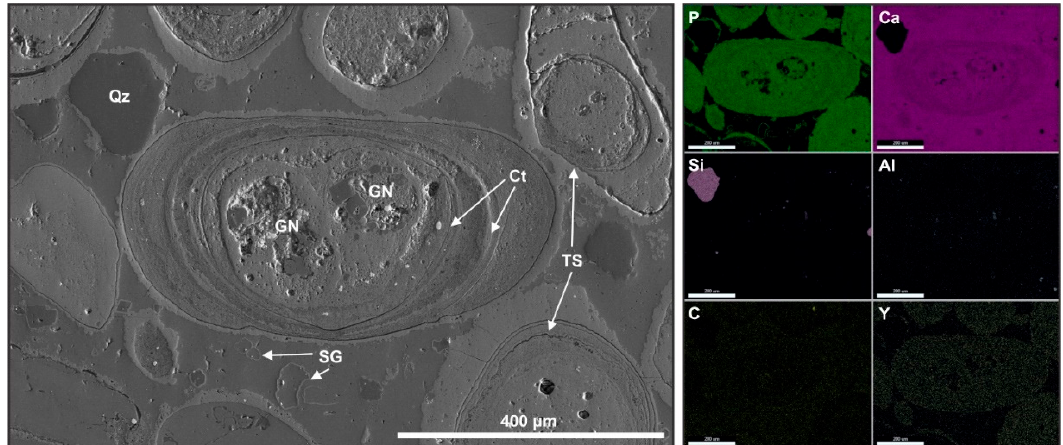
Figure 7. Detailed SEM image of sample MH6 centered on composite apatite coated grain, acquired with ET detector BSE mode, and SDD-EDS elemental maps of select major and trace elements. The grain in the center is formed by the agglutination of two apatite grains with aluminosilicate nuclei (GN) and multiple cortices (Ct) representing episodes of phosphatization. The grain on the bottom right corner has an internal truncation surface (TS) near the edge, and the grain on the upper right corner has an irregular shape with multiple internal, and an external truncation. Other grains are phosphatized skeletal fragments (SG) with moldic porosity later infilled by calcite, quartz (Qz), and aluminosilicates. All apatite grains and some silicates have a surrounding overgrowth rim of apatite. Cement is predominantly calcite. Yttrium occurs as a trace element homogeneously disseminated in phosphatic phases.